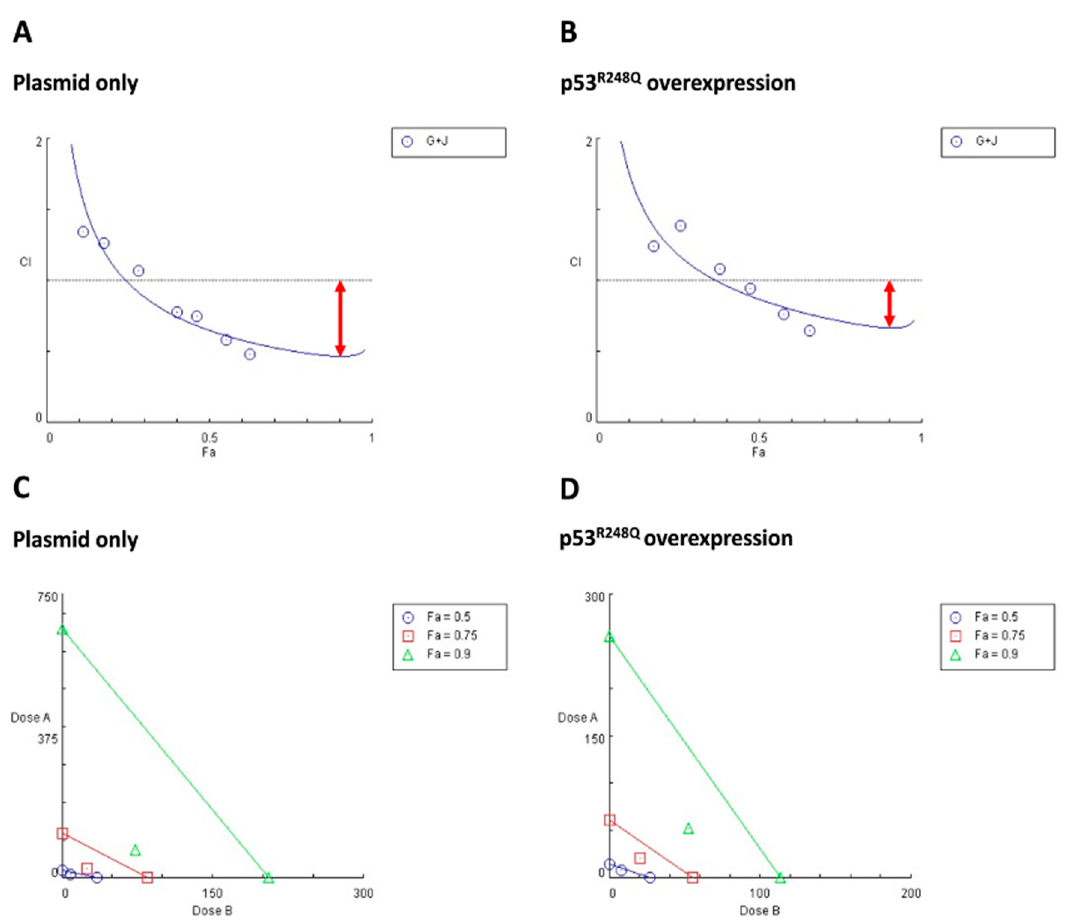
Figure 5. Synergistic effects of gefitinib and JNJ on OVCAR3 cells with different p53 statuses were shown in Fa-CI plots and isobolograms. Based on the Chou and Talalay methods, the combination index (CI) values were calculated using CompuSyn software to determine the degree of synergistic effectiveness of the drug combination. The analysis revealed that overexpression of p53 R248Q reduced the synergistic effect of gefitinib and JNJ. ( A , B ) In the Fa-CI plots, the fraction affected (Fa; from zero to one) represented the ratio of dead cells-to-total cells in response to drug treatments. Circled symbols indicated the CI values of each Fa. The CI values provided a quantitative definition of synergistic (CI < 1), additive (CI = 1), and antagonistic (CI > 1) effects derived from the drug combination. (G + J: gefitinib + JNJ) ( C , D ) In the isobolograms, the individual doses of JNJ (represented by x -axis) and gefitinib (represented by y -axis) that achieved 90% (Fa = 0.9), 75% (Fa = 0.75), and 50% (Fa = 0.5) inhibitory effects were indicated by green lines, red lines, and blue lines, respectively. Symbols (ED 90 was marked as green triangles; ED 75 was marked as red squares; ED 50 was marked as blue circles) above the lines, on the lines, and below the lines represented antagonistic, additive, and synergistic effects, respectively. When the symbols were located below and distant from the lines, it represented strong